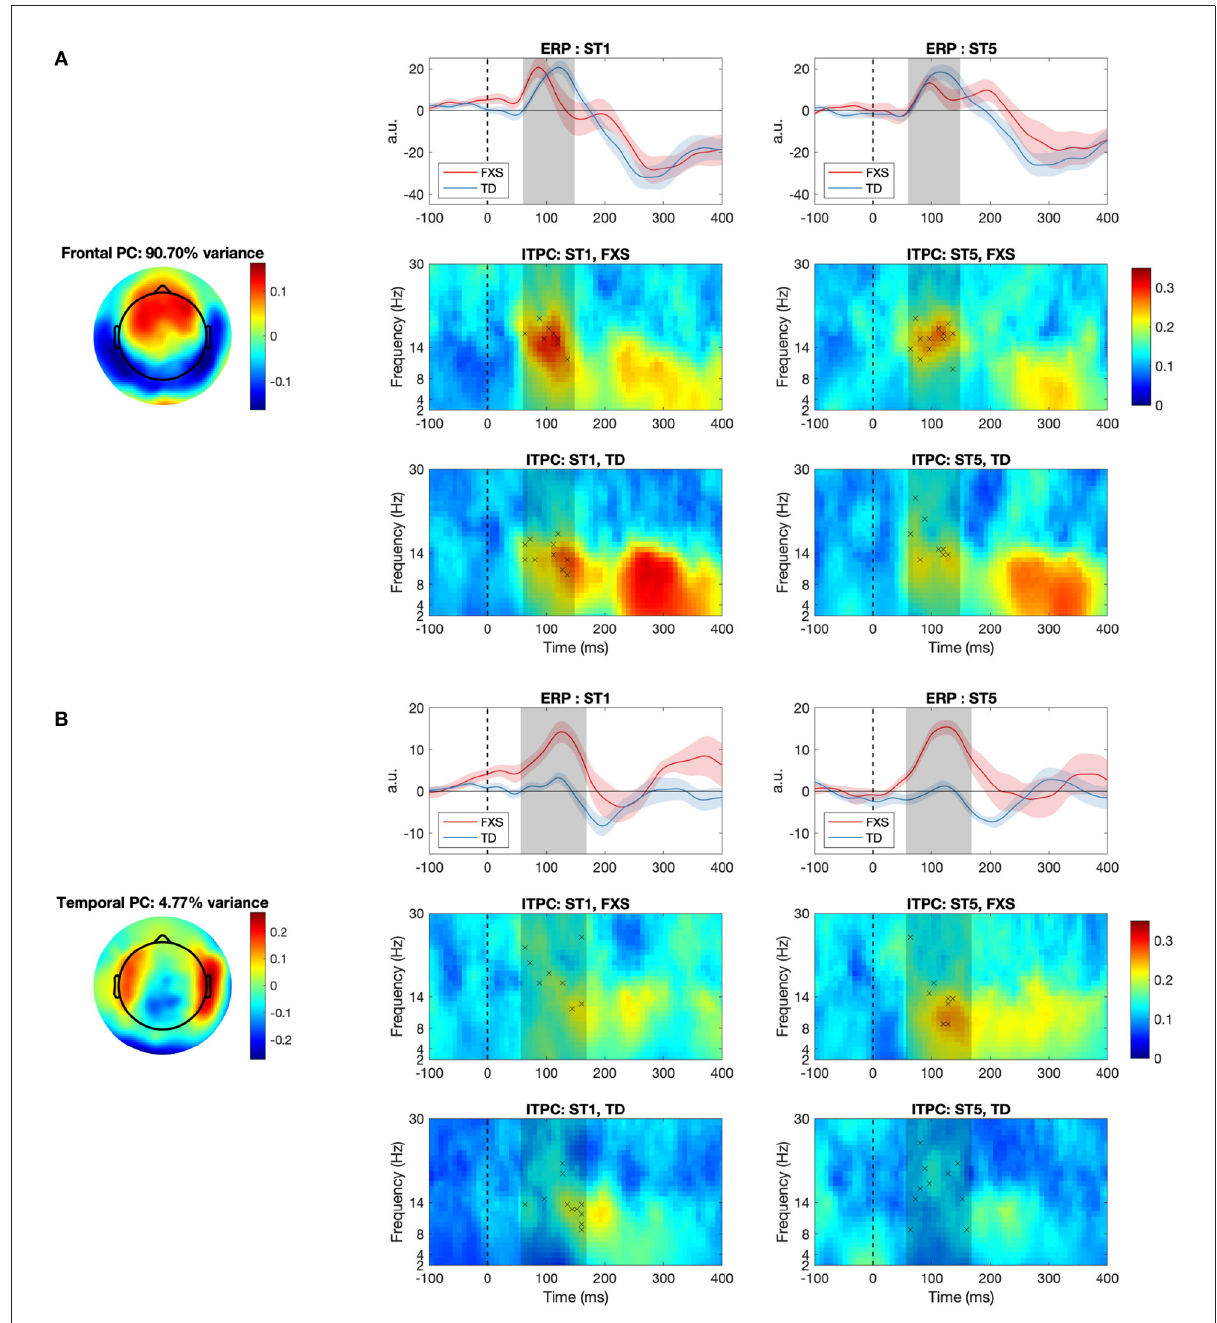
FIGURE3 The (A) frontal and (B) temporal principal component (PC) and their associated event-related potential (ERP) and inter-trial phase coherence (ITPC) for the FXS and the TD group. Dashed lines represent the stimulus onset; the red and blue shaded areas denote standard error of the mean; the gray shaded areas denote the P1 window identified by a non-parametric statistical analysis; crosses in the ITPC plots indicate where maximum ITPC was identified for each participant. a.u., arbitrary